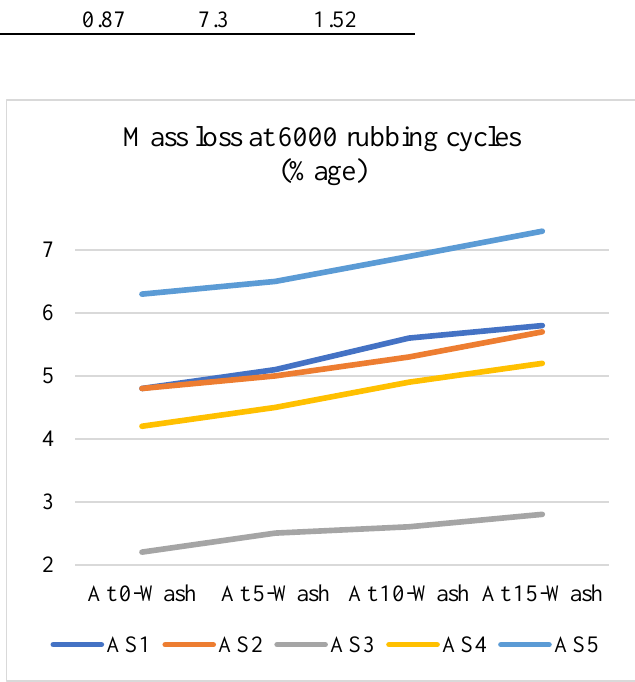
Fig. 4. Mass loss at 6000 rubbing cycles at various washing